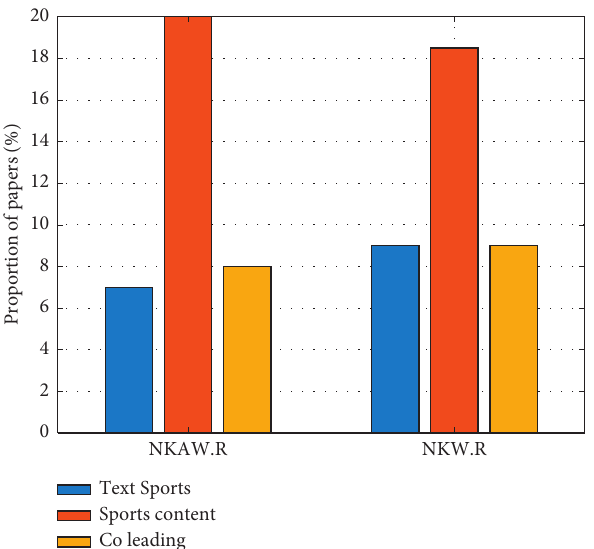
Figure 7: Percentage of papers covered by new keywords and new keywords in collaborative research